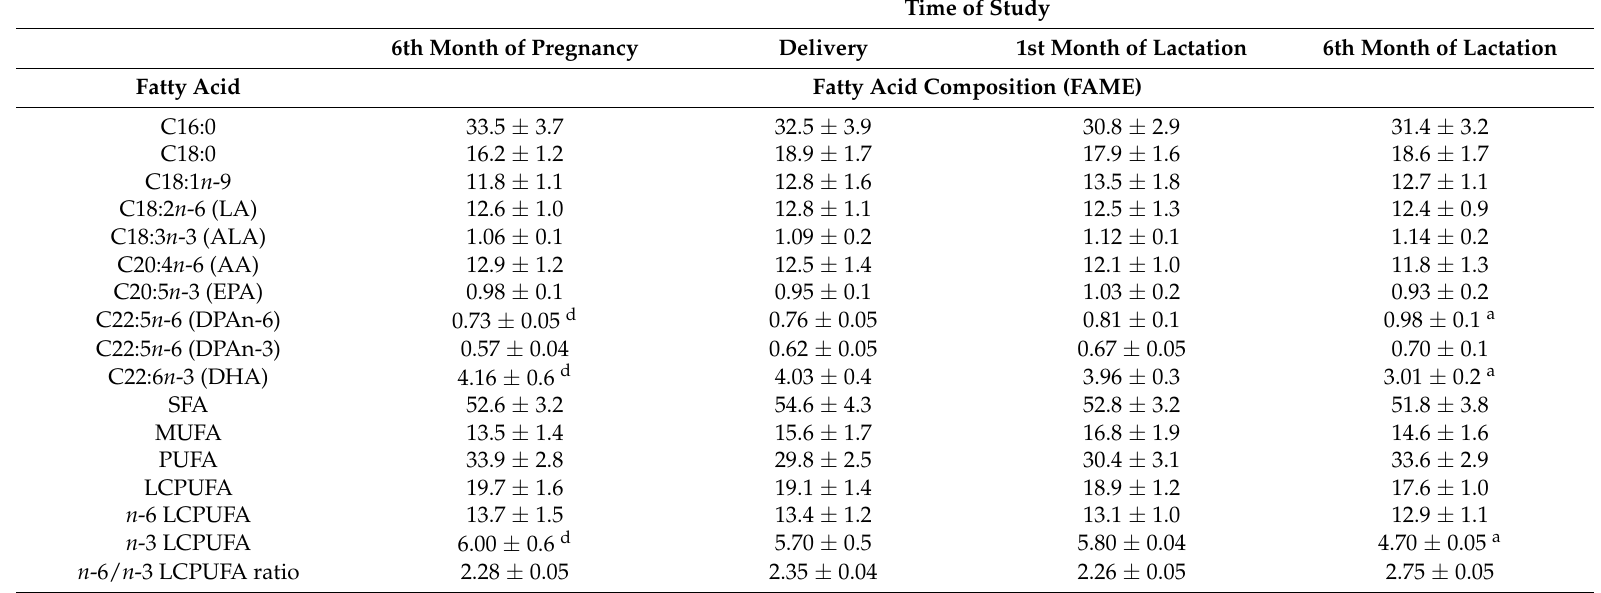
Table 5. Fatty acid composition in erythrocyte phospholipids of the women during the pregnancy and lactation